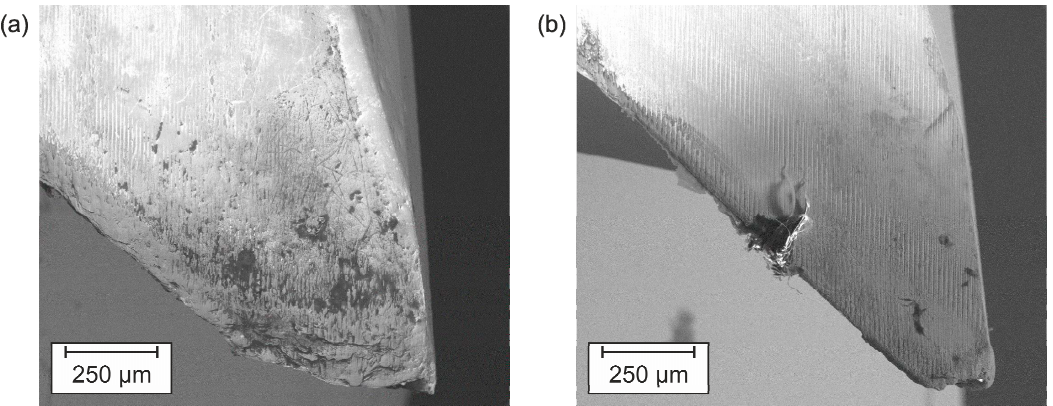
Figure 4. SEM images of the cutting edge after milling in ( a ) laboratory air and ( b ) an XHV-adequate environment.